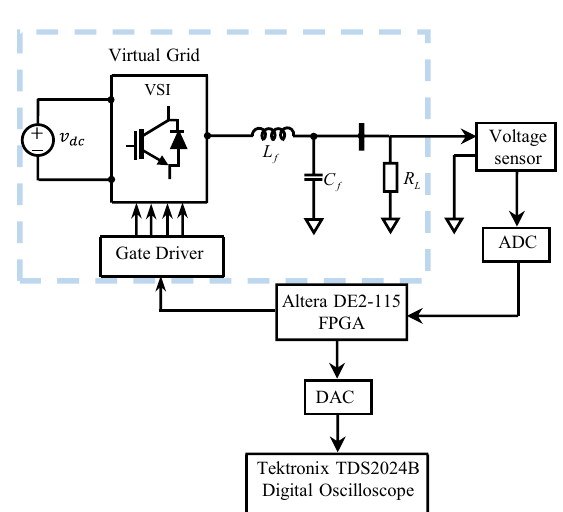
Fig. 13 The block diagram of the small-scale experimental